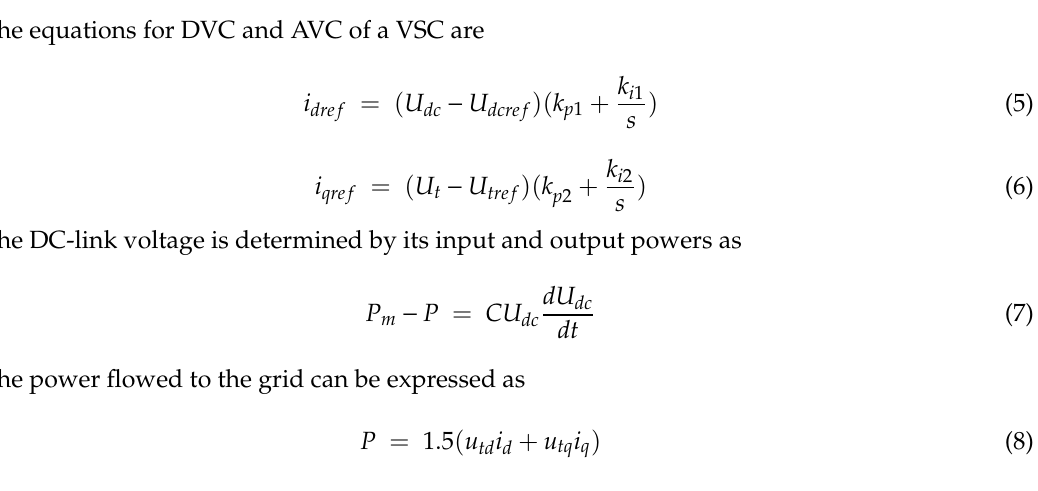
Figure 2. A system comprised of two VSCs in parallel connection to a weak grid: ( a ) circuit diagram; ( b ) VSC control system.